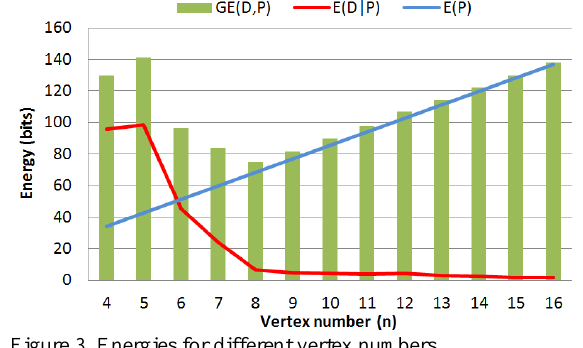
Figure 3. Energies for different vertex